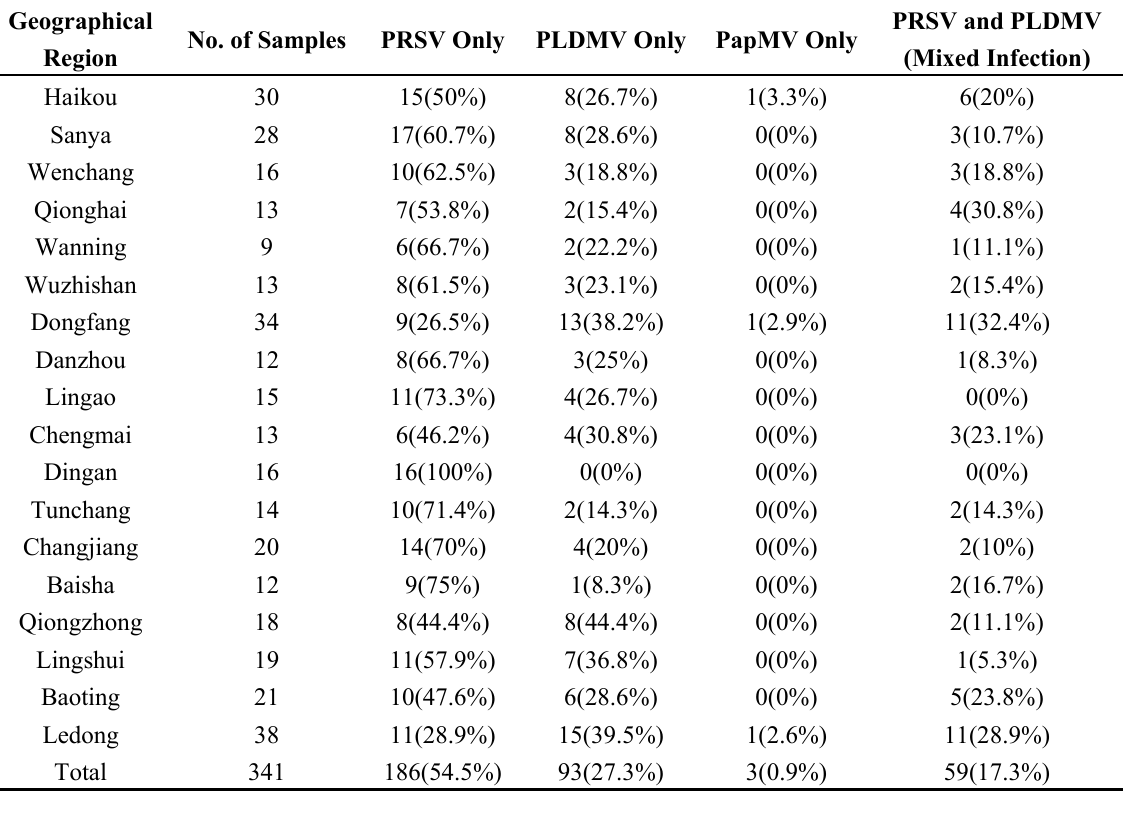
Table 2. Detection of Papaya ringspot virus (PRSV), Papaya leaf distortion mosaic virus (PLDMV), and Papaya mosaic virus (PapMV) in papaya plants from different geographical regions of Hainan Island.